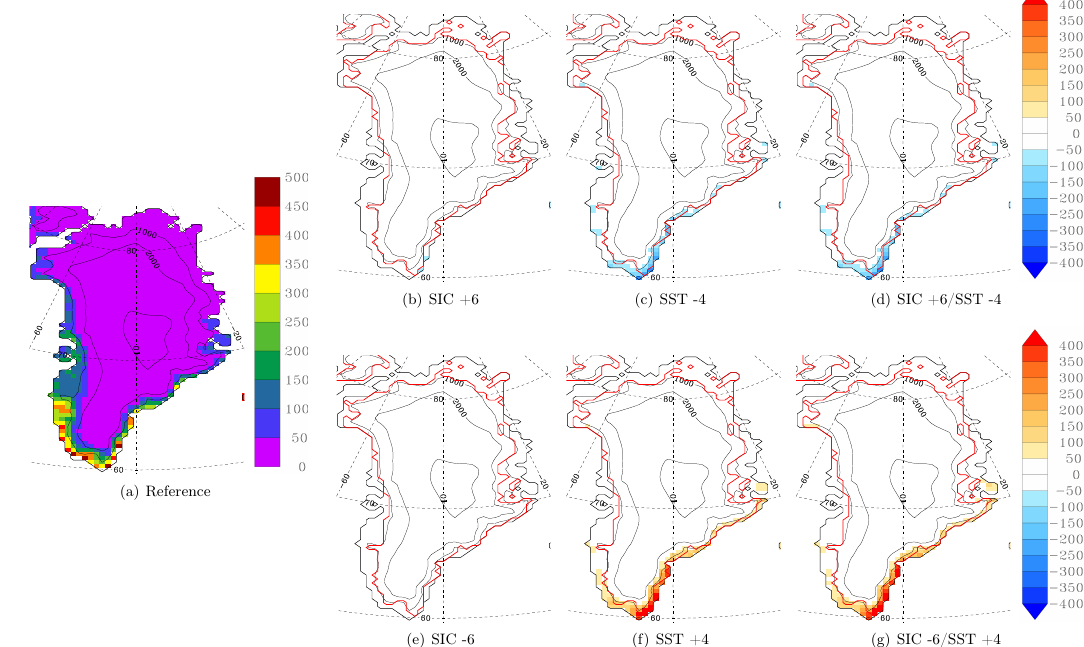
Figure 4. Annual mean cumulated rainfall (mmWEyr − 1 ) for the reference run (a) over 2007–2012. Difference in annual mean cumu- lated rainfall (mmWE yr − 1 ) between (b) SIC + 6, (c) SST − 4, (d) SIC + 6/SST − 4, (e) SIC − 6, (f) SST + 4, (g) SIC − 6/SST + 4 experiments and the reference run. The thick red line defines the GrIS area in MAR.